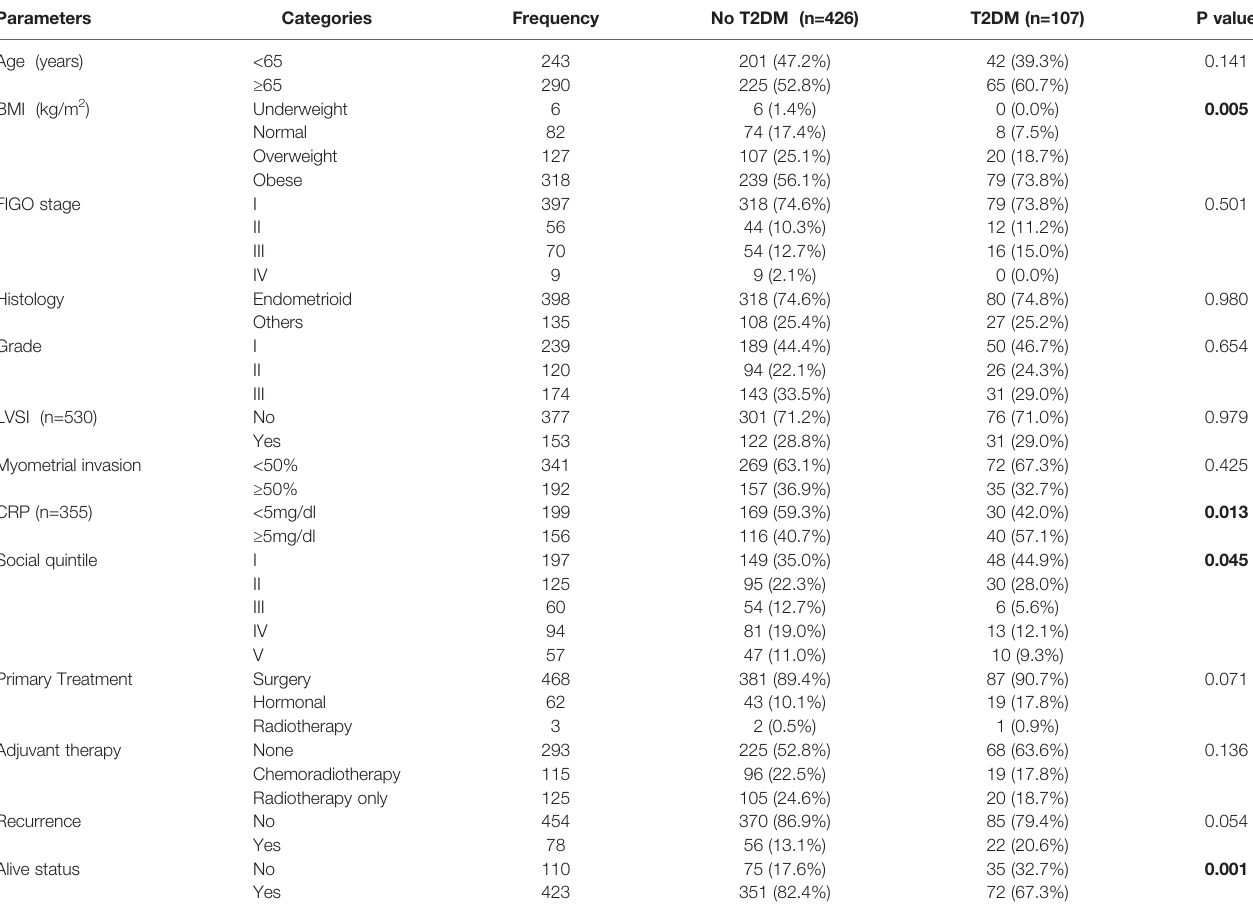
TABLE 2 | Baseline socio-demographic characteristics strati fi ed by T2DM status.